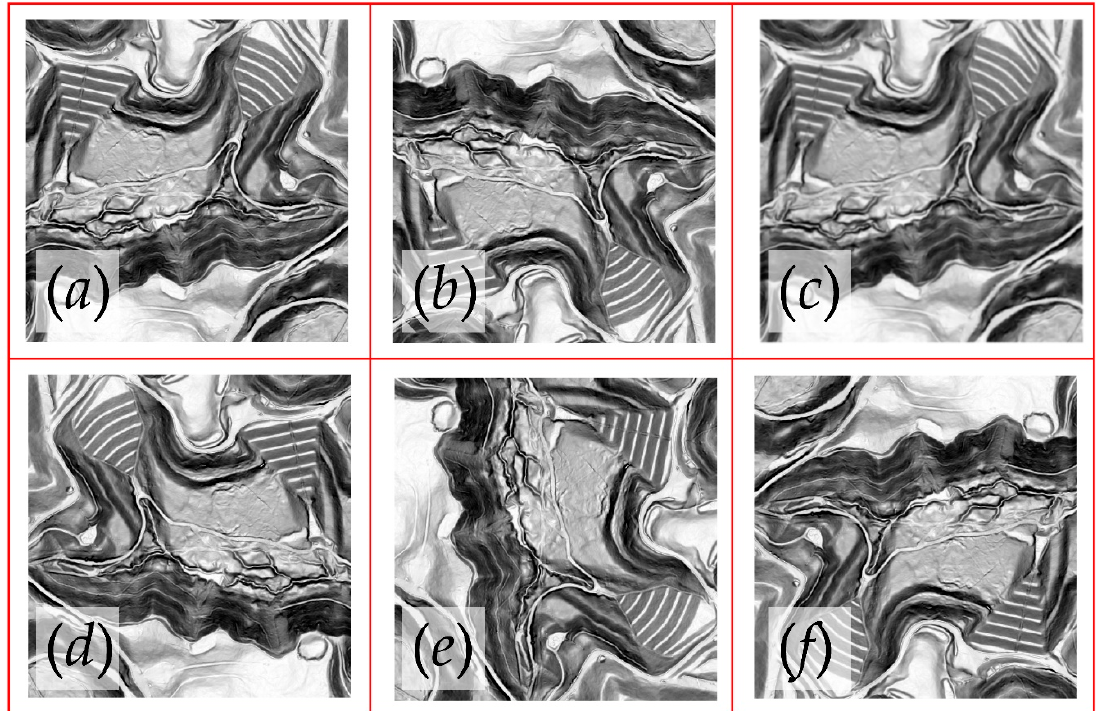
Figure 4. Example image augmentations applied to minimize overfitting. ( a ) Original image chip. ( b ) Vertical flip. ( c ) Gaussian blur. ( d ) Horizontal flip. ( e ) Rotate 90° clockwise. ( f ) Rotate 180° clockwise.